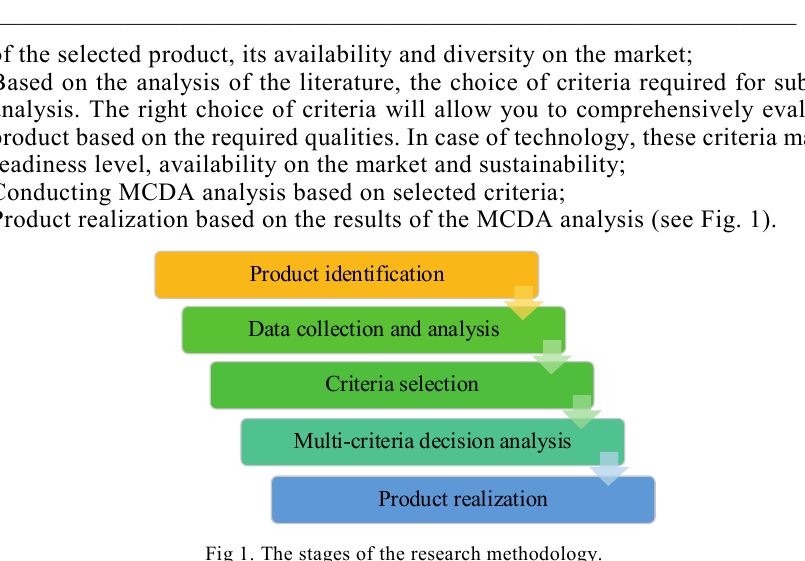
Fig 1. The stages of the research